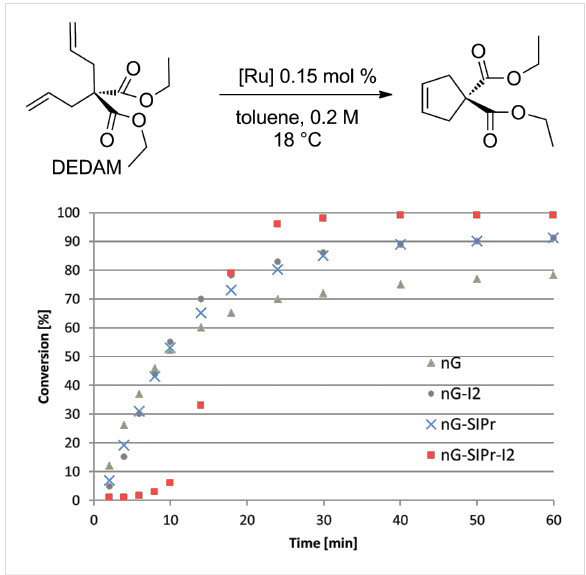
Figure 2: Reaction profiles for RCM of DEDAM; toluene, 0.2 M, 18 °C, [Ru] 0.15 mol %; conversion determined by